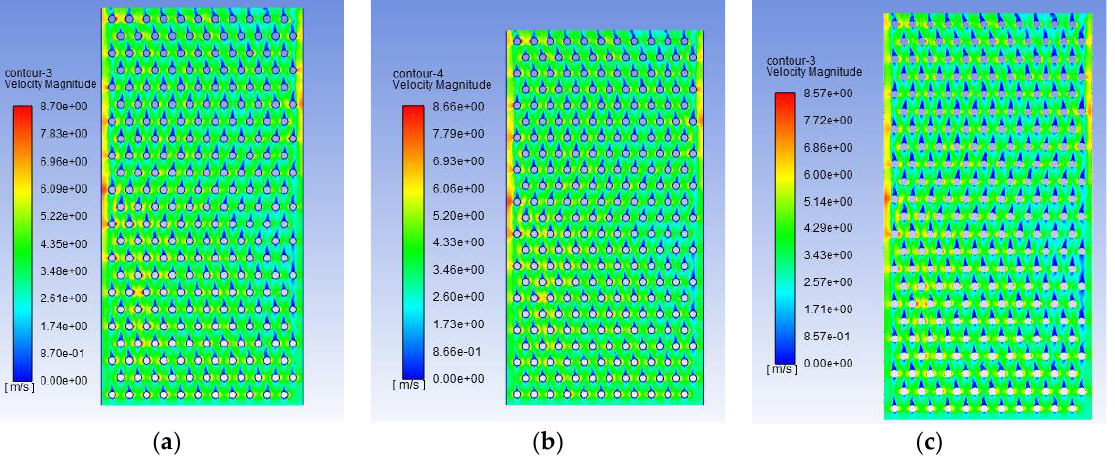
Figure 6. The velocity distributions corresponding to different relative humidities of inlet ambient 80% RH = . ( b ) Velocity nephogram for air. ( a ) Velocity nephogram for air. ( a ) Velocity nephogram for RH 0 = 80%. ( b ) Velocity nephogram for RH 0 = 85%. ( c ) Velocity 0 90% RH = . nephogram for RH 0 = locity nephogram for 0